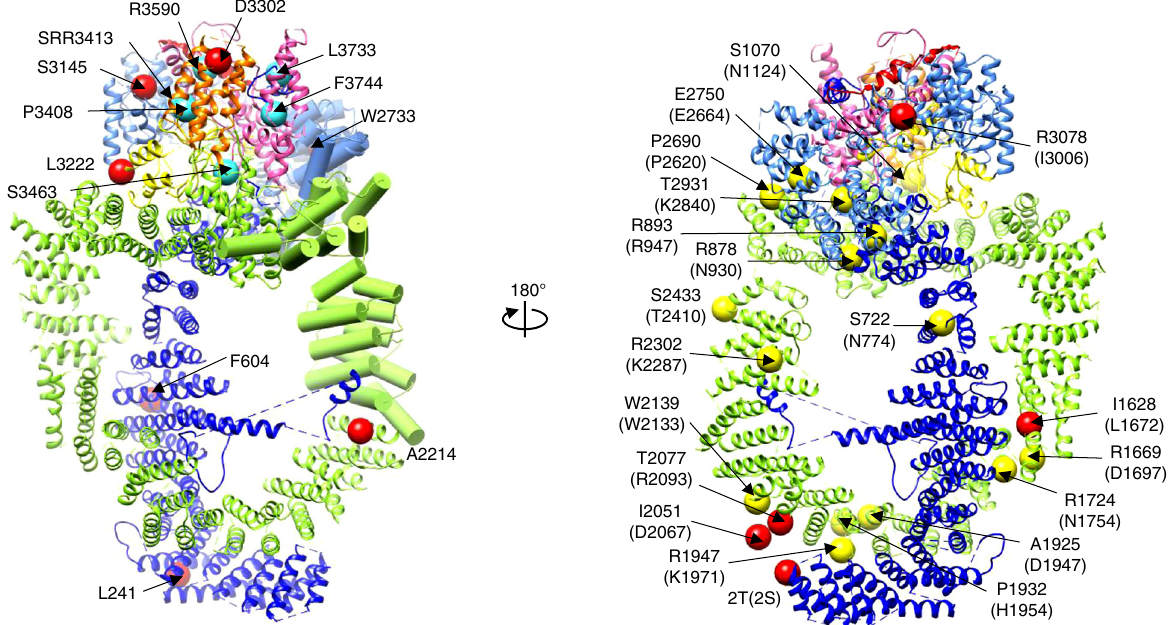
Fig. 7 Scaffolding function of the Tra1/TRRAP. a Mutations disrupting the interaction of Tra1 with VP16 activator are mapped to the structure elements as red spheres. The Tra1 mutations causing growth defects are shown as large cyan spheres. The prominent VP16 binding region corresponding to TRD1 – TRD2 and HEAT 42R-51R of the Tra1 (residue 2233 – 2836) is highlighted in pipes. b The TRRAP mutations in human cancer are shown as yellow spheres and modi fi cation sites (acetylation and phosphorylation) reported for TRRAP are shown as red spheres with structural elements colored as in Fig.